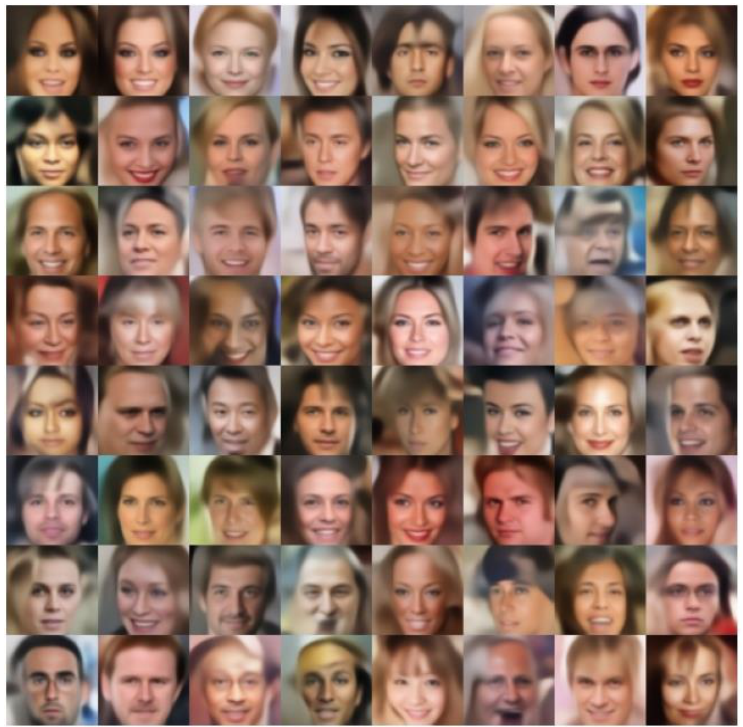
Figure 12. Representative images of AVB (Adversarial Variational Bayes) [43].